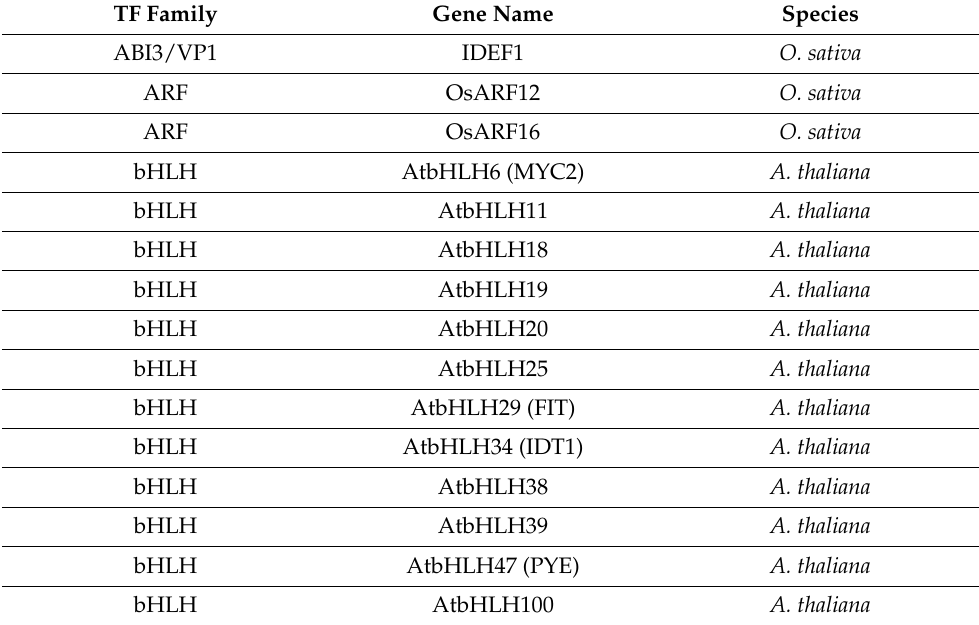
Table 1. Transcription factors involved in the control of iron homeostasis in